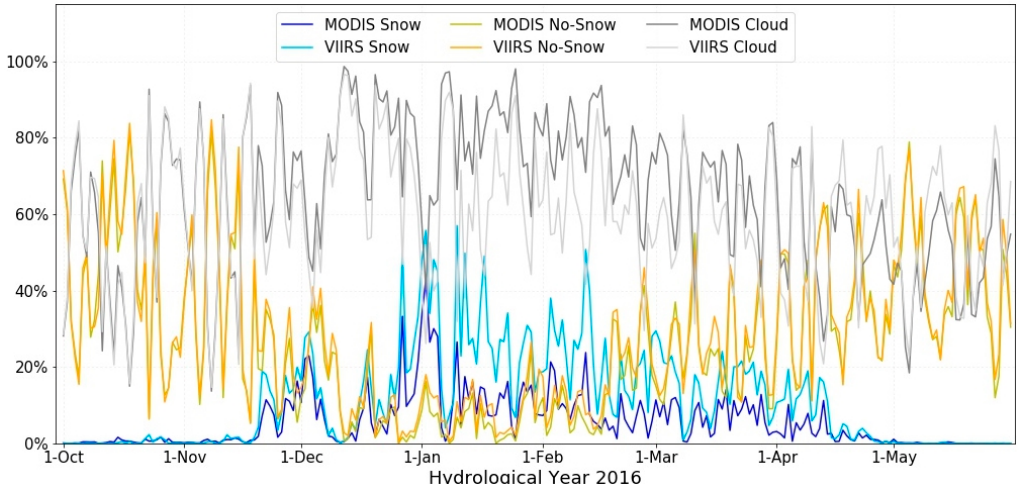
Figure 3. Line plots illustrating MODIS and VIIRS total snow, no-snow and cloud pixels concerning each day of the 2016 hydrological year.